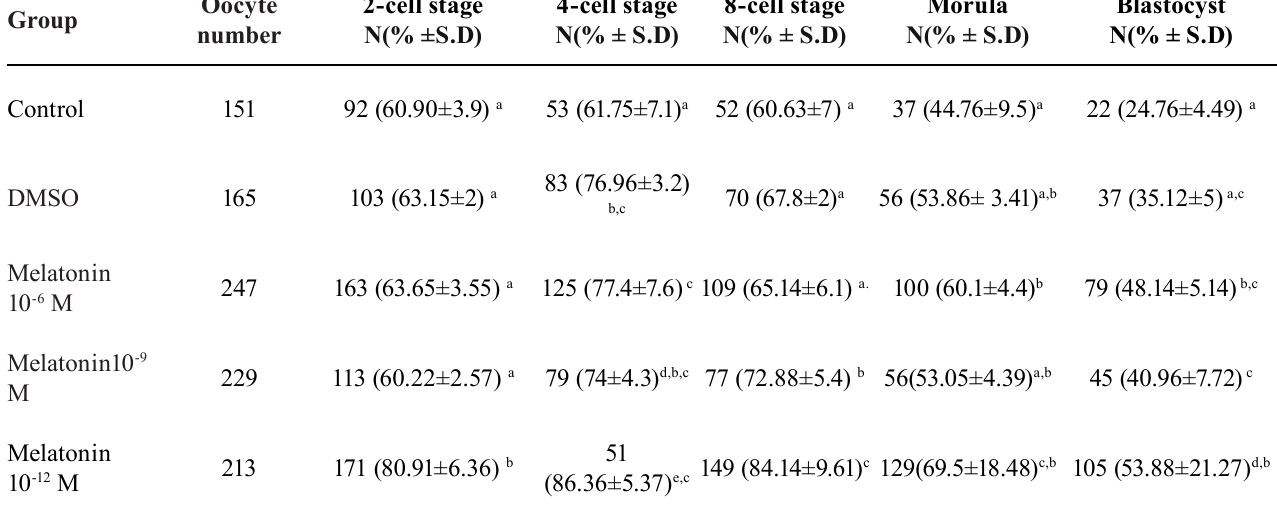
TABLE I – D evelopment of the IVF/2-cell mouse embryo cultured in the medium supplemented with different concentrations of melatonin The means of 2-cell, 4-cell, and 8-cell embryos as well as morula and blastocyst were compared by the non-parametric analysis test (Kruskal-Wallis). Data are presented as mean ± SEM. a, b, c,d Numbers with different superscript letters in the same column differ significantly